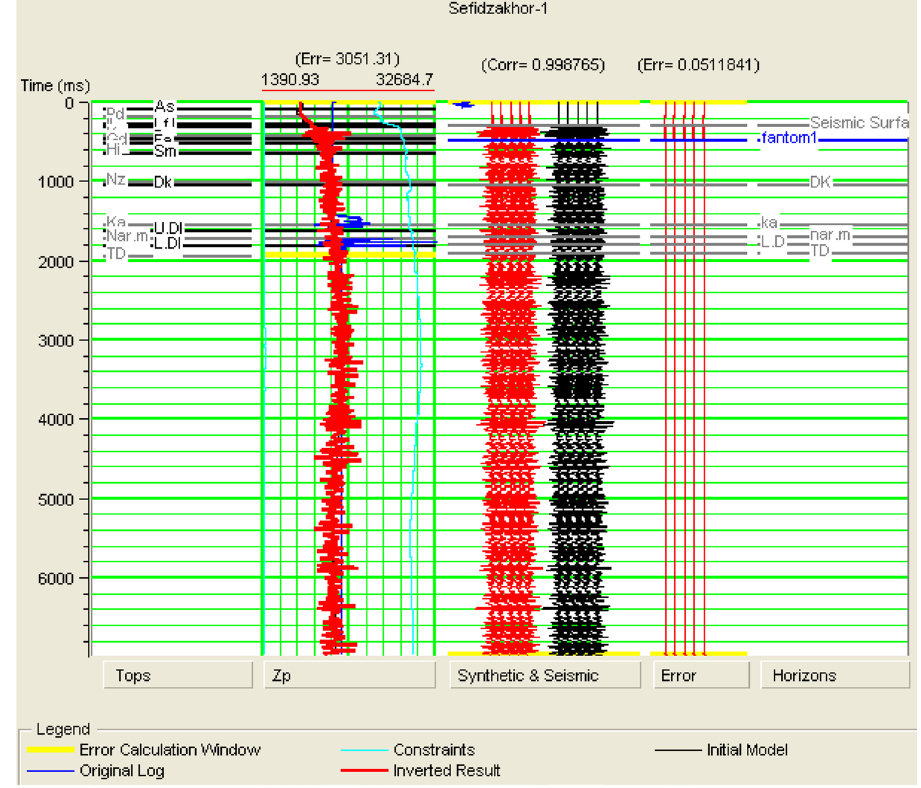
Fig. 5 Synthetic seismogram and seismic data correlation with the errors. The red traces are synthetic, and the black one is the seismic trace. The red lines on the right-hand side of the seismic trace show the error between the synthetic used for inversion and real seismic data. The red line is the Zp across the well obtained from inversion, the black line is Zp from the initial guess model, and the blue line is Zp from the